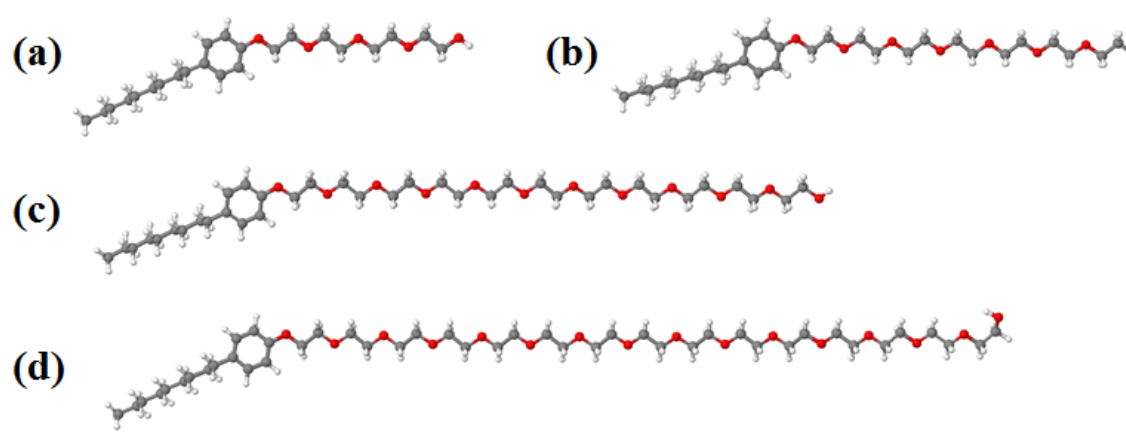
Figure 1. Optimized geometries for: ( a ) NPE-4, ( b ) NPE-7, ( c ) NPE-11 and ( d ) NPE-15 surfactants. Color atoms:  O;  C and ○